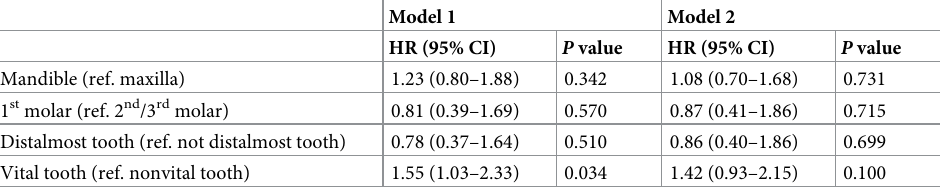
Table 2. Results of the influence of the location and vital/nonvital tooth on CAD/CAM composite crown compli- cations, assessed using the Cox proportional hazard model ( n =